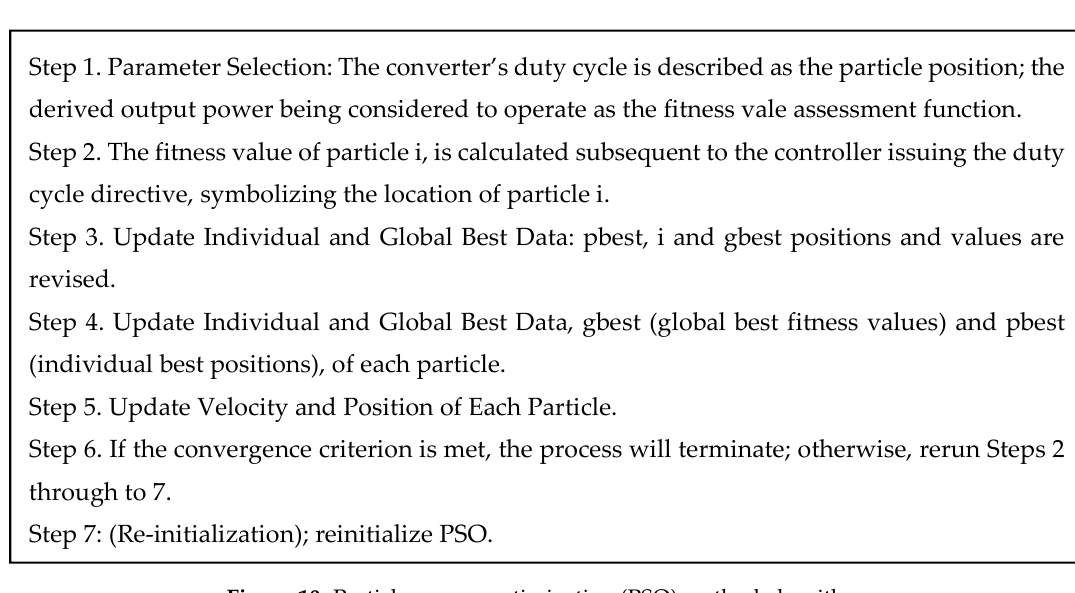
Figure 10. Particle swarm optimization (PSO) method algorithm.